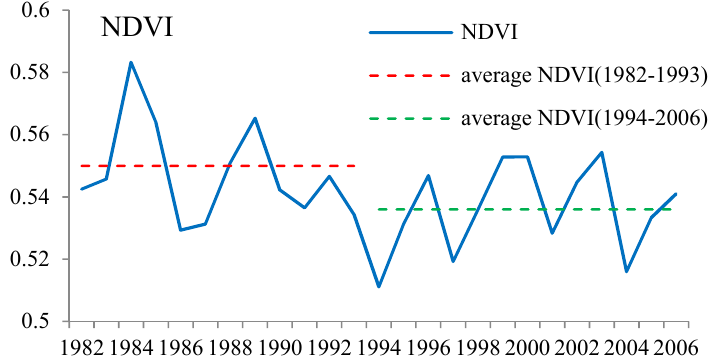
Figure 4. Change of annual maximum NDVI in the upstream of Laichau station (1982–2006).